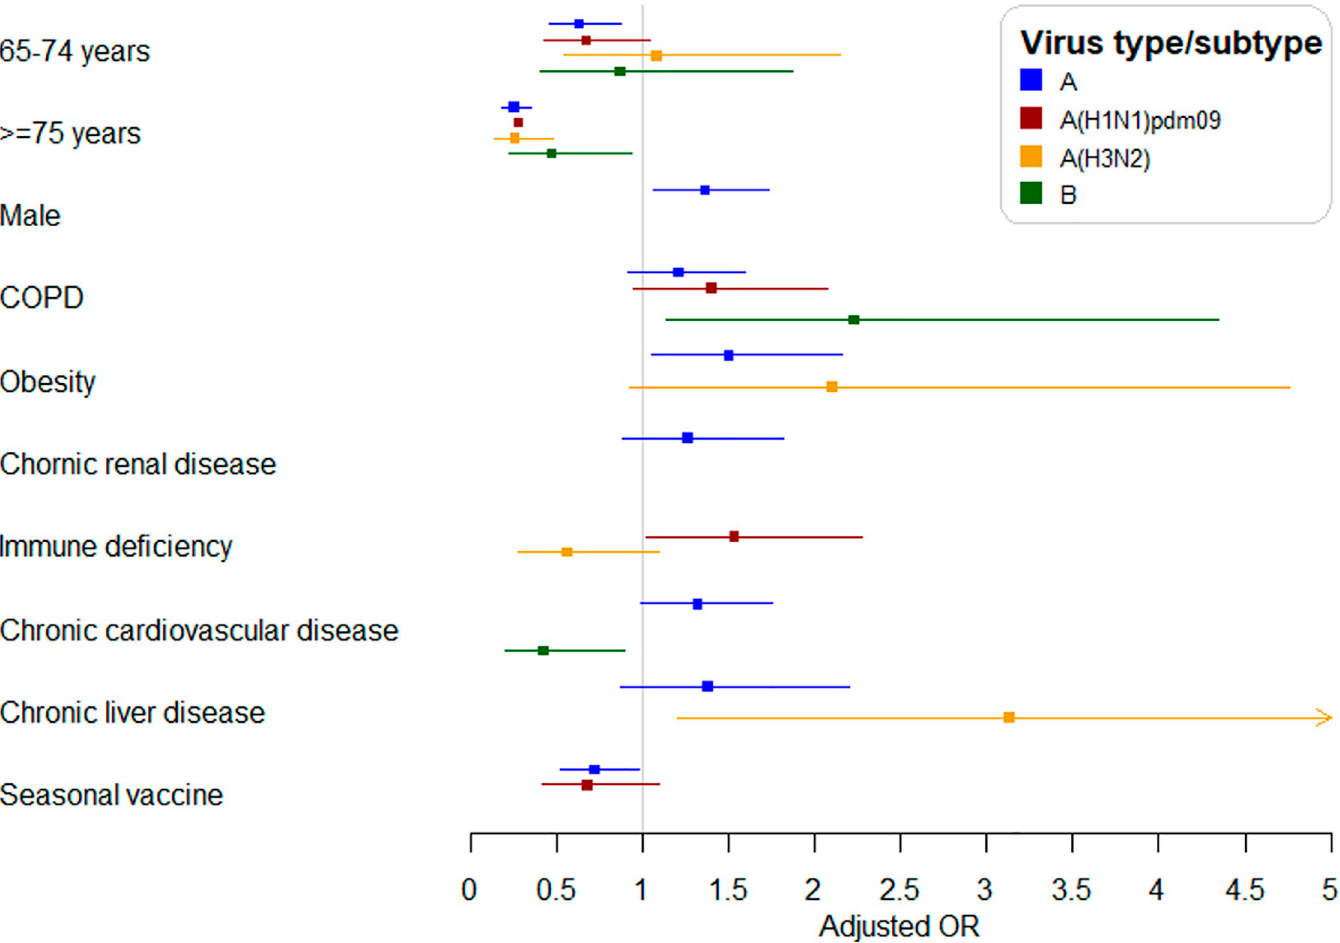
Fig 1. Factors associated with ICU admission in hospitalized patients according to influenza type and subtype.